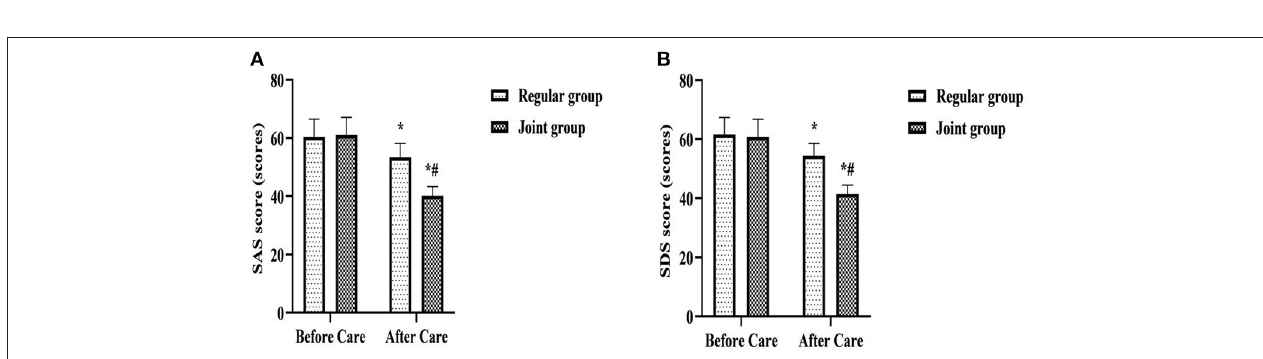
FIGURE 2 | Comparison of QLQ-C30 scores of the two groups. (A) Symptom domain score; (B) Functional domain score; (C) Single question score. Compared with the same group before care, * P < 0.05; Compared with the regular group after care, # P < 0.05.